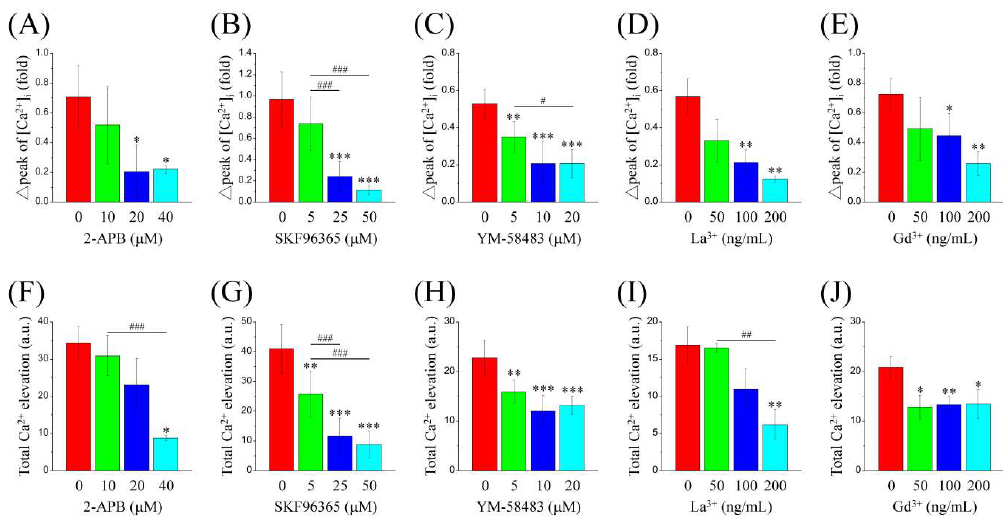
Figure 7. Dose-response inhibition of PDGF-BB-mediated Ca 2+ elevation by the Ca 2+ mobilization inhibitors. MEF-STIM1 −/− cells were starved in a serum-free medium and then loaded with Fura-2/AM and co-treated with ( A , F ) 0–40 μM 2-APB, ( B , G ) 0–50 μM SKF96365, ( C , H ) 0–20 μM YM58483, ( D , I ) 0–200 ng/mL La 3+ , and ( E , J ) 0–200 ng/mL Gd 3+ for 30 min. Cells were then stimulated with 100 ng/mL PDGF-BB at 2 mM extracellular Ca 2+ . Intracellular Ca 2+ ([Ca 2+ ] i ) was monitored using a single-cell fluorimeter for 15 min for at least three independent experiments. The bar charts show ( A – E ) initial Ca 2+ peak and ( F , J ) total Ca 2+ elevation following the addition of PDGF-BB. Bars represent mean ± SEM. *,#: p < 0.05; **,##: p < 0.01; ***,###: p < 0.001 by one-way ANOVA with Dunnett’s post-hoc test.